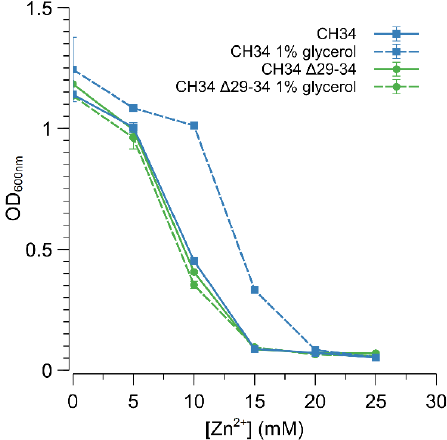
Figure 5. Impact of glycerol on the increased zinc resistance of C. metallidurans CH34. Dose–response experiments with CH34 (blue) and CH34 ∆ 29-34 (green) without (full line) and with (dashed line) 1% glycerol. The average values of three independent experiments with standard deviations are shown.